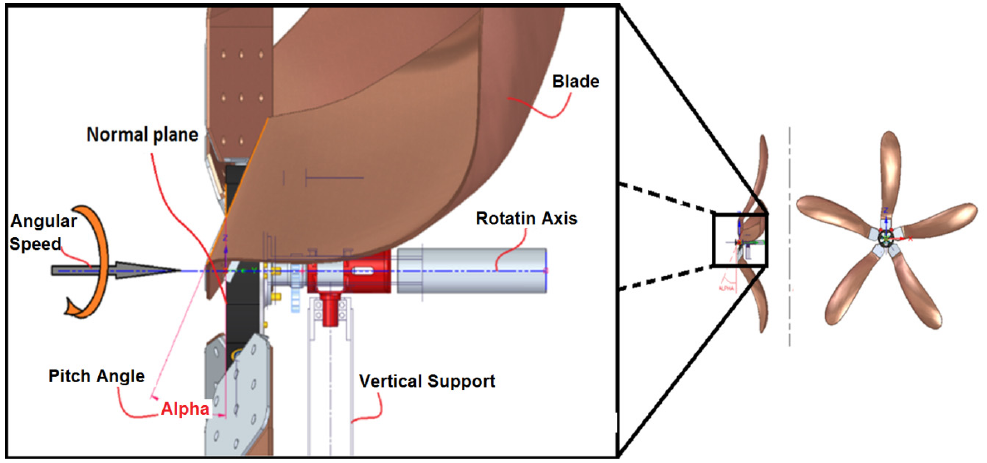
Figure 6. Rotor bio-inspired by the Petra Volubilis seed.